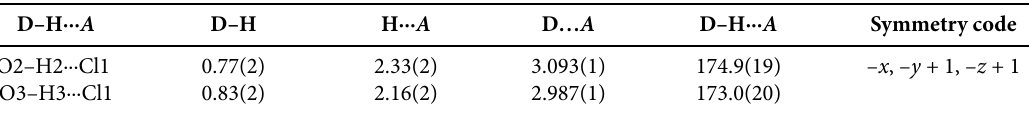
Fig. 2. The hydrogen bonding interactions between uncoordinated hydroxyl group of ligand and the chloride counter anions in complex 1 along b axis. Table 3. Hydrogen bonding (Å) and angles (°) in complex 1